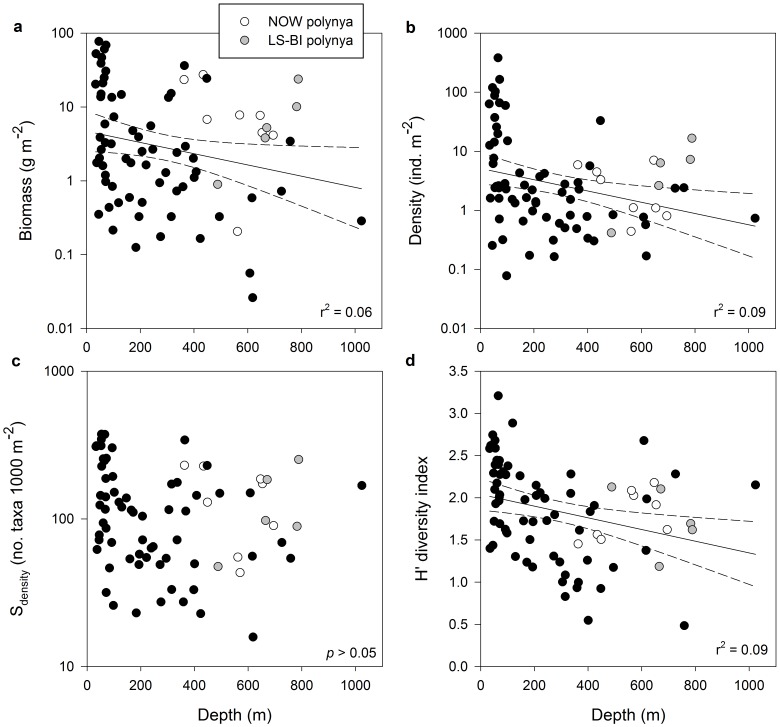
Relationships of benthic community characteristics with depth. Stations sampled underneath Lancaster Sound-Bylot Island polynya (LS-BI; gray circles) and NOW polynya (white circles) are highlighted.(a) biomass (g m−2); (b) density (ind. m−2); (c) Sdensity (no. of taxa 1000 m−2); (d) Shannon-Wiener's diversity index (H'). Coefficients of determination of significant linear regressions (p<0.05) are shown and dashed lines represent 95% confidence intervals.